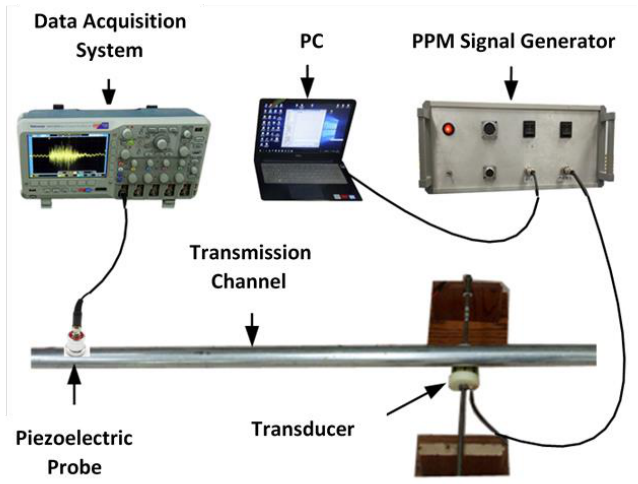
Figure 12. Schematic diagram of the experimental setup.